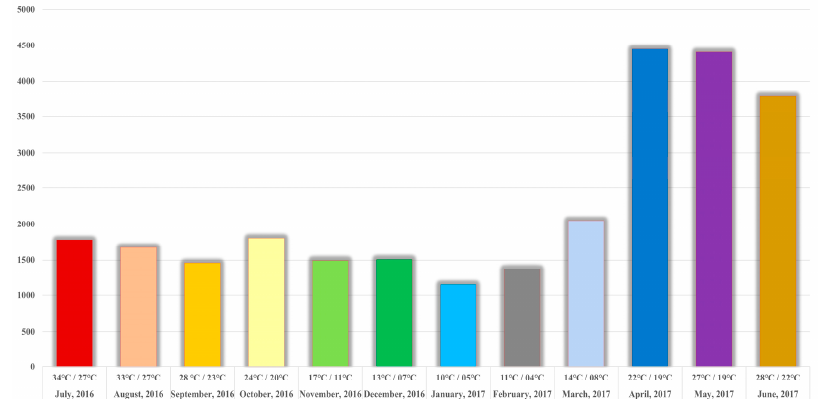
Figure 10. Variation in the number of park visitors with respect to temperature.